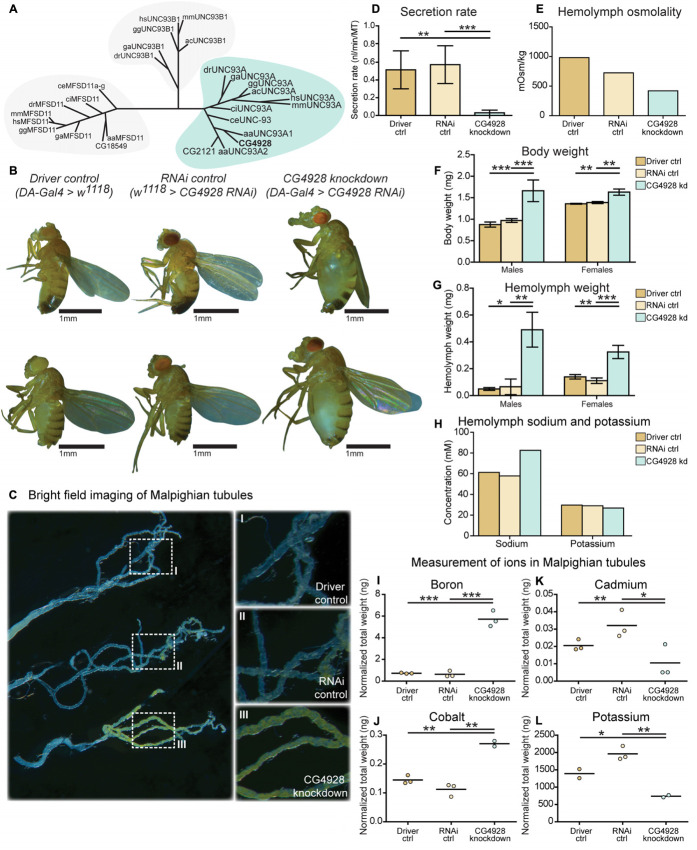
CG4928 is evolutionary conserved and crucial for normal renal function in D. melanogaster. Related proteins to UNC93A were searched for using a hidden Markov model. (A) UNC93A had orthologs in A. aegypti, A. carolinensis, C. elegans, C. intestinalis, D. rerio, D. melanogaster, G. aculeatus, G. gallus, and M. musculus. Closest relatives were UNC93B1 and MFSD11. CG4928 was ubiquitously knocked down using Da-Gal4. (B)
CG4928 knockdown males and females developed edema in 28°C compared with Driver control and RNAi control. Bright-field images displaying the Malpighian tubules obtained from Driver control, RNAi control, and CG4928 knockdown females were captured where (C)
CG4928 knockdowns showed an accumulation of yellow-colored pigments in the Malpighian tubules, close-up (C) I–III. Ramsay assay was performed on Malpighian tubules from adult females (n = 50). Secretion rate was measured after 2 h of secretion, average secretion rate (±SD) was plotted, and differences were calculated using one-way ANOVA with Bonferroni’s corrections (*p < 0.05, **p < 0.01, ***p < 0.001). (D)
CG4928 knockdown flies had a lower secretion rate compared with controls. Body and hemolymph samples were collected to measure osmolality, differences in body and hemolymph weight, and concentrations of sodium and potassium. Then, 20 μl of hemolymph sample from adult flies (CG4928 knockdown n = 500, Driver control n = 800, RNAi control n = 800) was collected to measure osmolality and sodium and potassium concentrations. (E)
CG4928 knockdowns had lower osmolality. Body and hemolymph weight were measured in males and females (n = 30); weight was calculated against the number of flies. Graphs represent mean (±SD); differences were calculated with Kruskal–Wallis and Dunn’s correction (*p < 0.05, **p > 0.01, ***p > 0.001). CG4928 knockdown flies were heavier, (F) body and (G) hemolymph weight, than controls and were found to have (H) 38.7% higher concentration of sodium and 8.6% lower concentration of potassium. Ion levels in Malpighian tubules from adult females were measured using ICP-SFMS (n = 2–3 per genotype, with Malpighian tubules from 60 flies in each). Data are plotted with a scatter plot; differences were calculated using unpaired t-test with Bonferroni’s correction (adjusted p-values: *p < 0.0492, **p < 0.0099, ***p < 0.0001). CG4928 knockdown flies had altered levels of (I) boron, (J) cadmium, (K) cobalt, and (L) potassium.